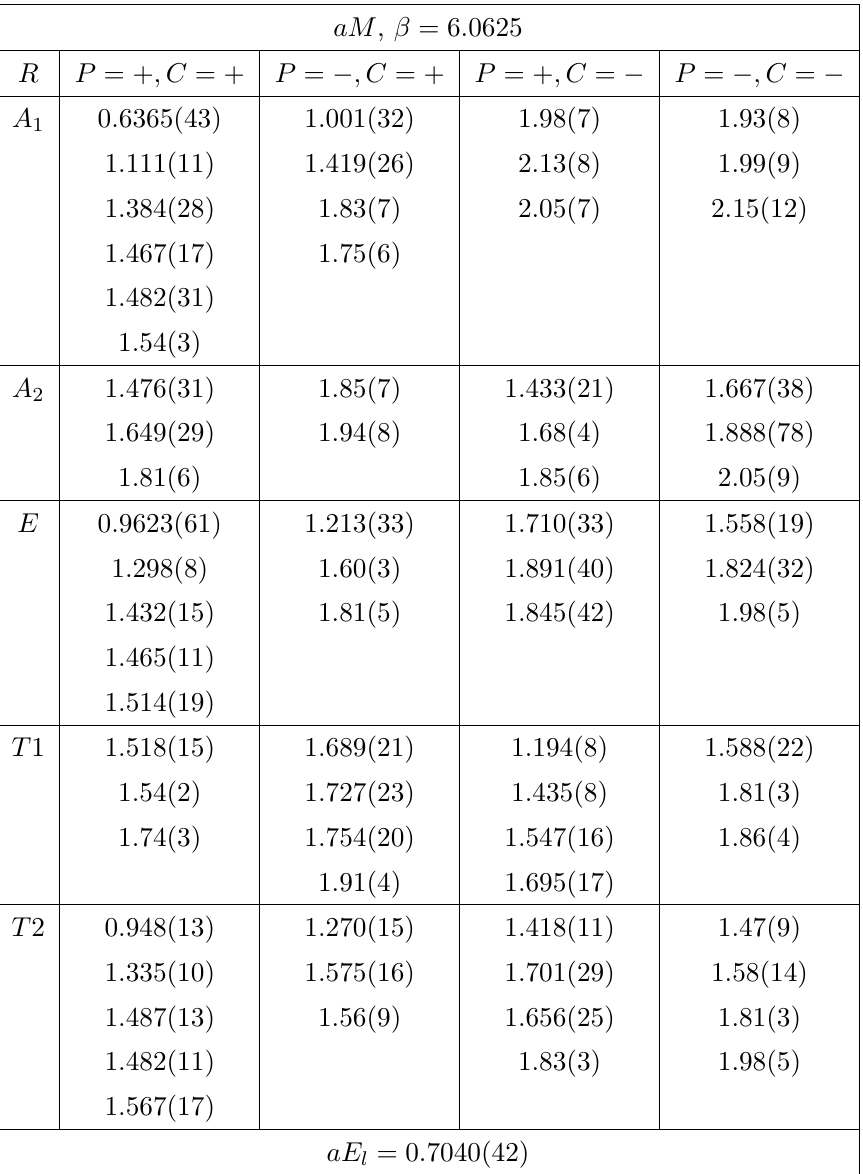
Table 10 . Glueball masses at β = 6 . 0625 on a 20 4 lattice for all representations, R , of the cube, and for both values of parity, P , and charge conjugation, C . Also the energy E l of a winding flux